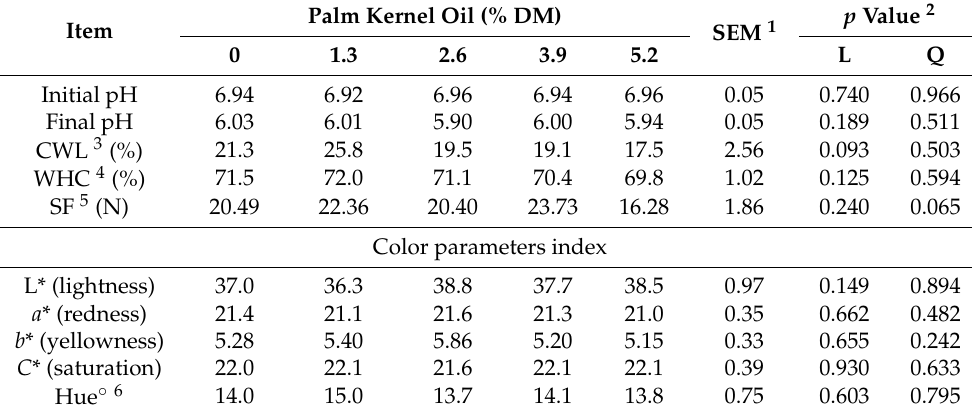
Table 3. Characteristics of Longissimus lumborum muscle of the lambs’ fed diets with different levels of palm kernel